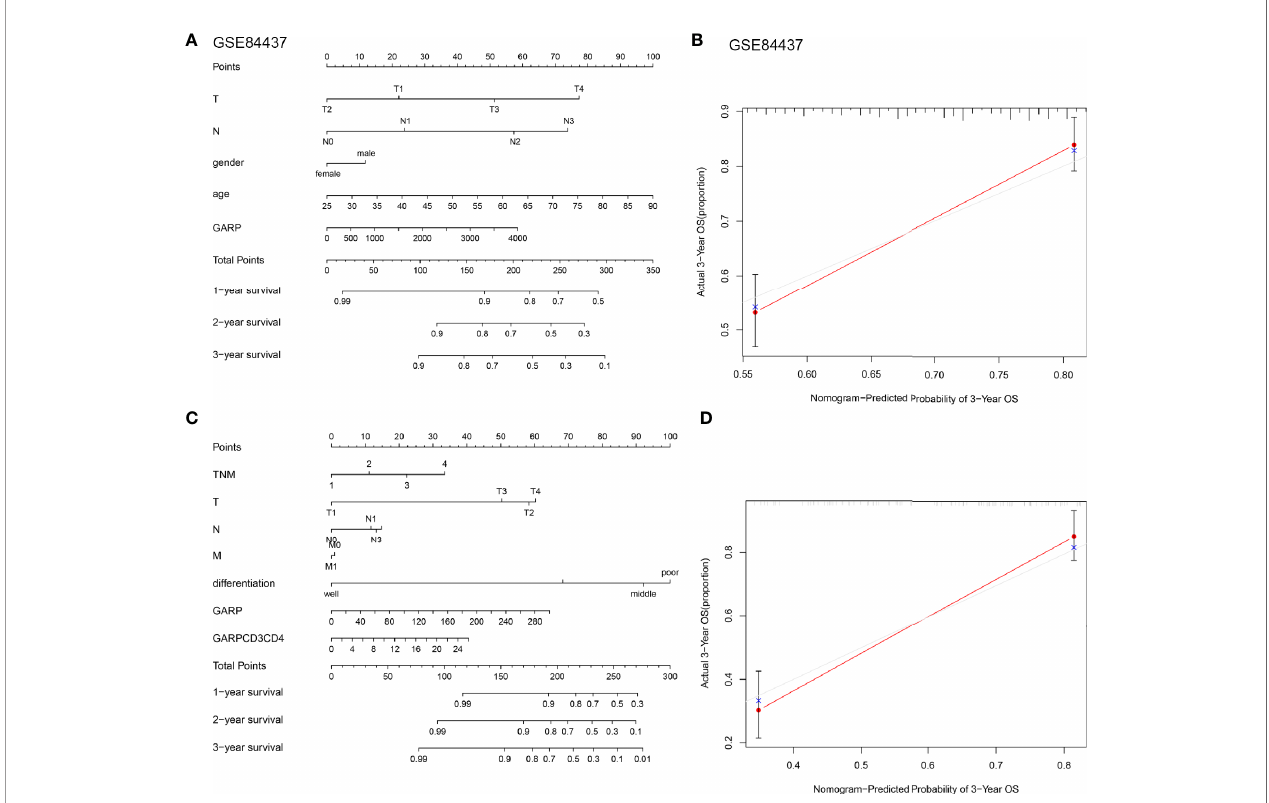
FIGURE 5 | (A, C) Nomograms were constructed with the GSE84437 and our research cohort for predicting the probability of 1-year, 3-year, and 5-year overall survival for GC patients. (B, D) Calibration plots of the nomograms for predicting the probability of overall survival at 3 years in the GSE84437 and our research cohort. The grey line represents the ideal nomogram, and the red line represents the observed